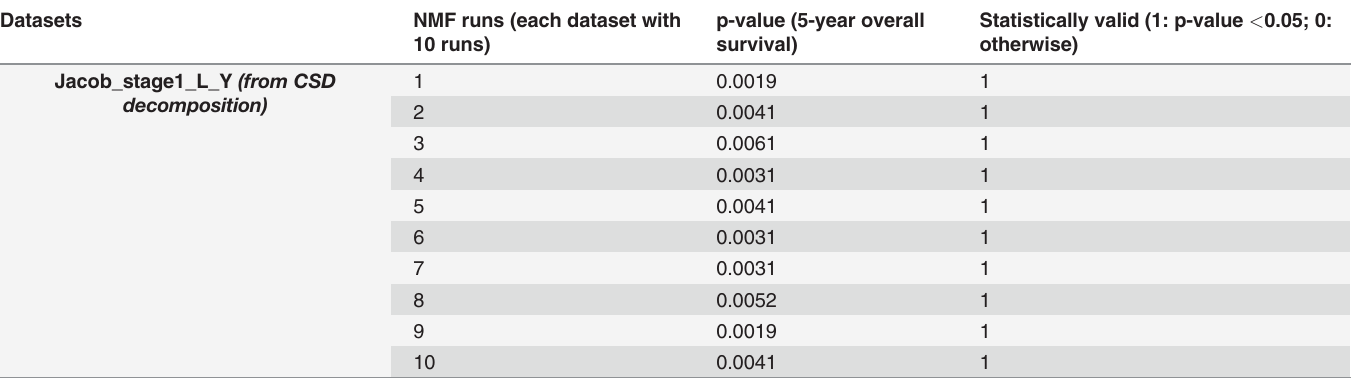
Refer to the testing results provided here and in the Supporting Information ( see S1 File for additional testing results ), which demonstrate the clear advantages of our new clustering frame- work. Our testing results show that: (1) the CSD approach facilitates the identification of gene markers, making potential gene markers stand out of the “ background ” ; (2) the MBI approach performs better on Y versus on M, where M is the original gene expression matrix and Y is the